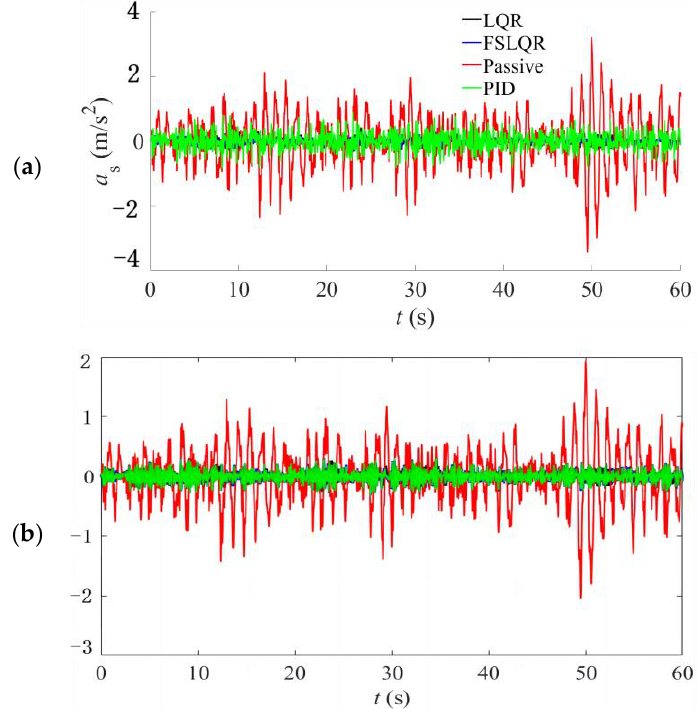
Figure 8. The tire ’ s loading coefficient responses of DTLc under random excitation, ( a ) under the national standard C-grade road surface, ( b ) under the national standard B-grade road surface.